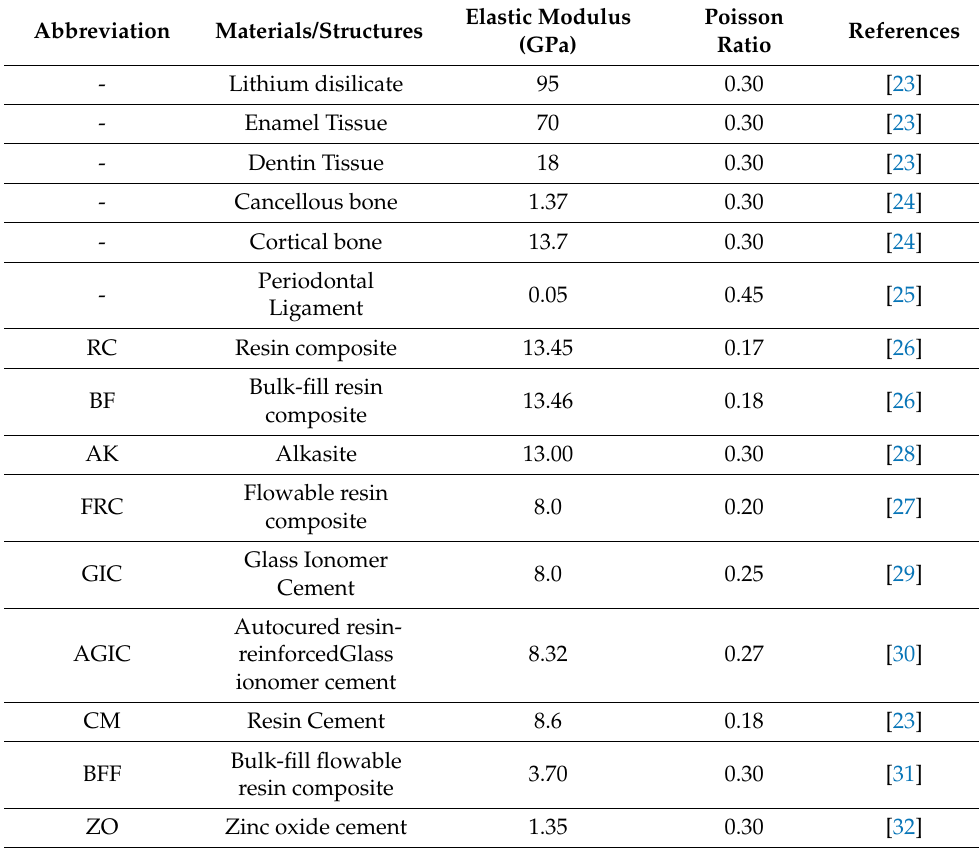
Table 1. Elastic moduli 1 of the materials used in this